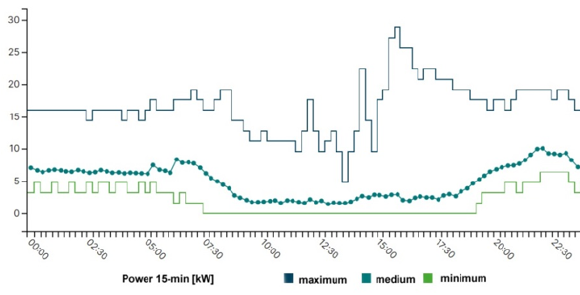
Figure 6: 15-minute profile of active power consumed in Sector 5 LSTP in the month of July 2019